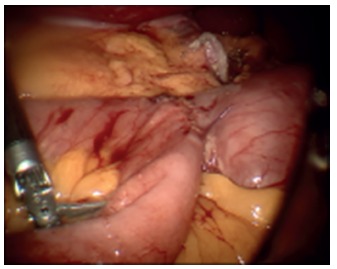
Creation of hand-sewn duodenoileal anastomosis